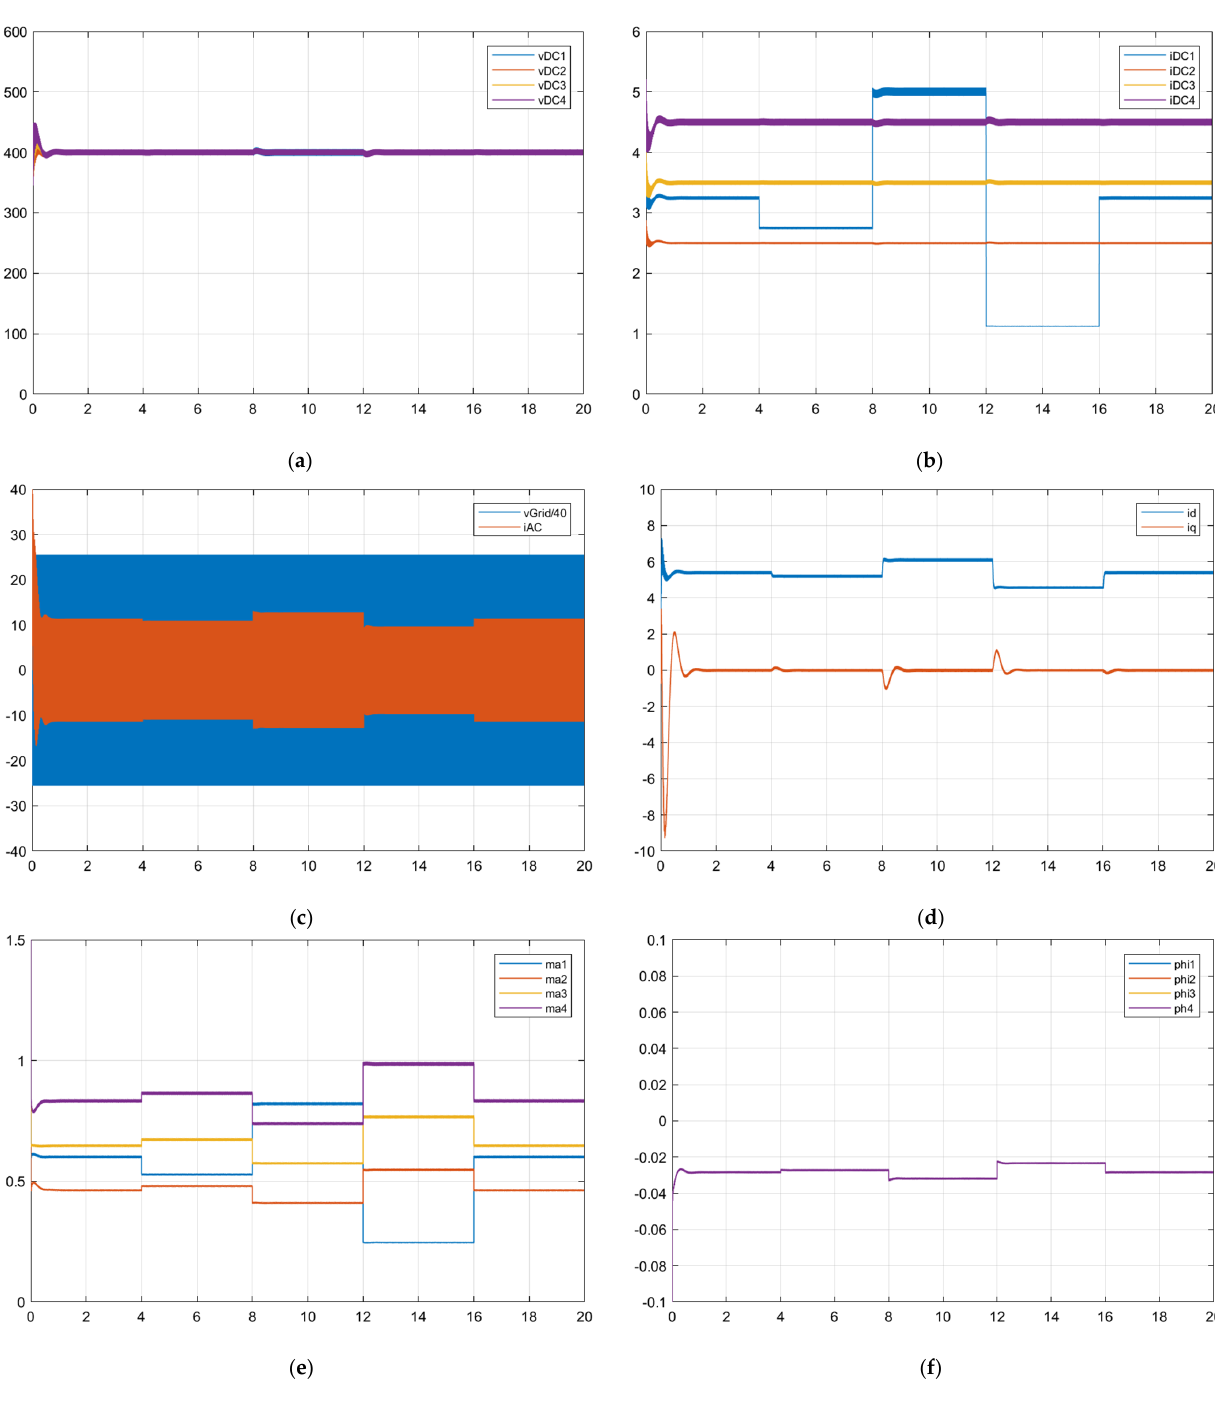
13 of 21 Figure 7. Overall high-level scheme in MATLAB/Simulink of the simulated MPST composed of four PEB s: ( a ) grid model and series connection of PEB HV terminals, ( b ) PEB models, ( c ) control strategy block and ( d ) visualization block. Table 2. Parameters used for the simulation. Parameter